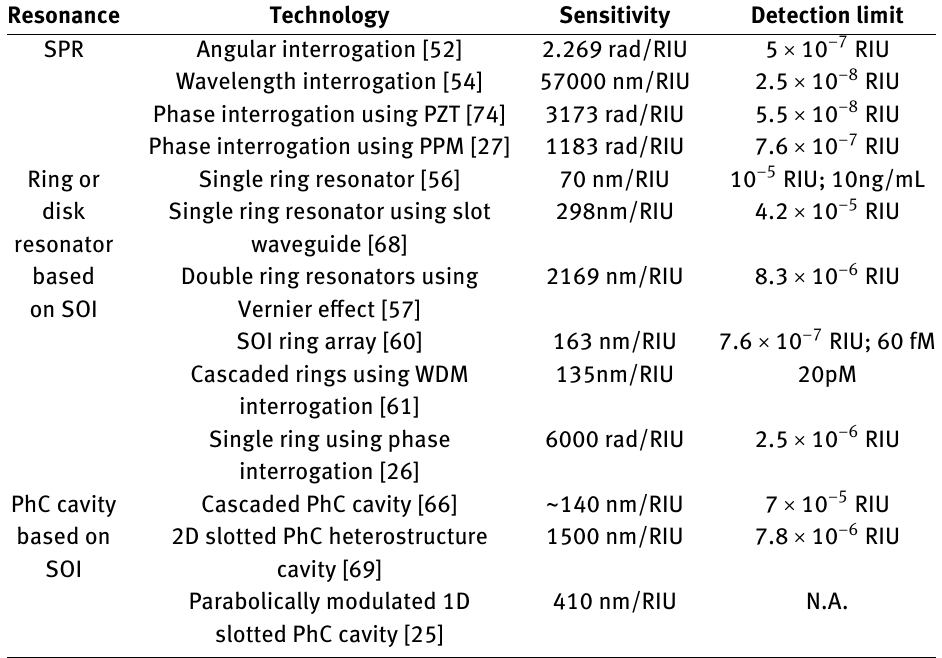
Table 1: Performance comparison of some resonance based refractive index sensors using SOI and SPR structures. N.A.: not described in the